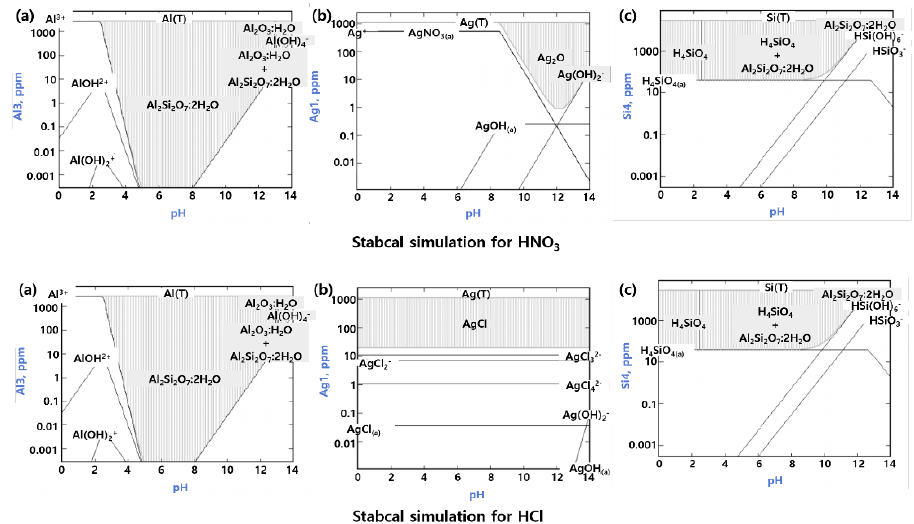
Figure 4. Stabcal simulation for HNO 3 and HCl reaction with ( a ) Al, ( b ) Ag, and ( c ) Si.